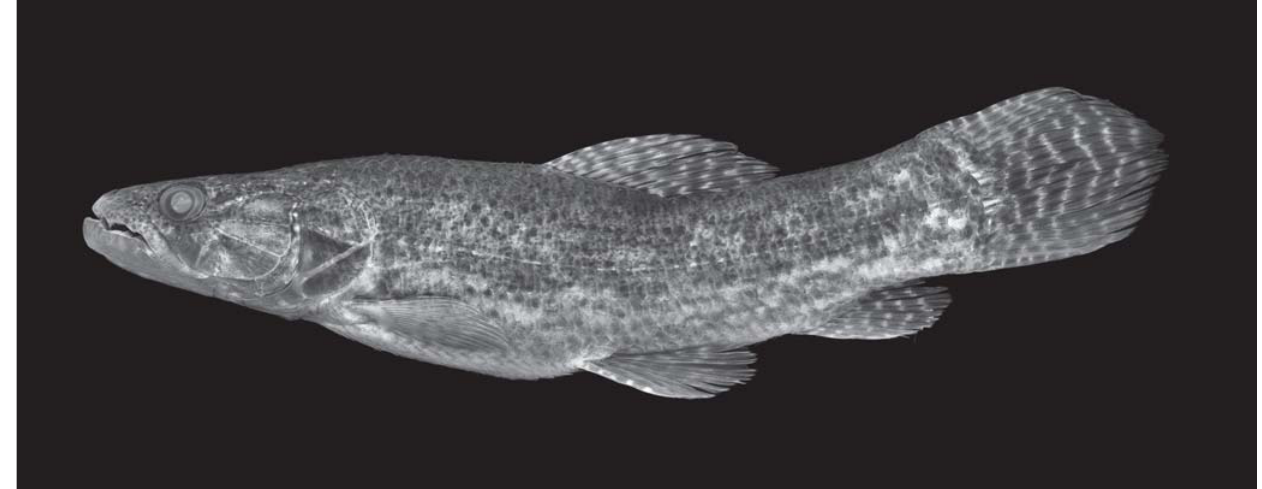
Fig. 4. Hoplias brasiliensis , neotype, MZUSP 45483, 162.9 mm SL, rio Paraguaçú near Iaçú, Bahia State,